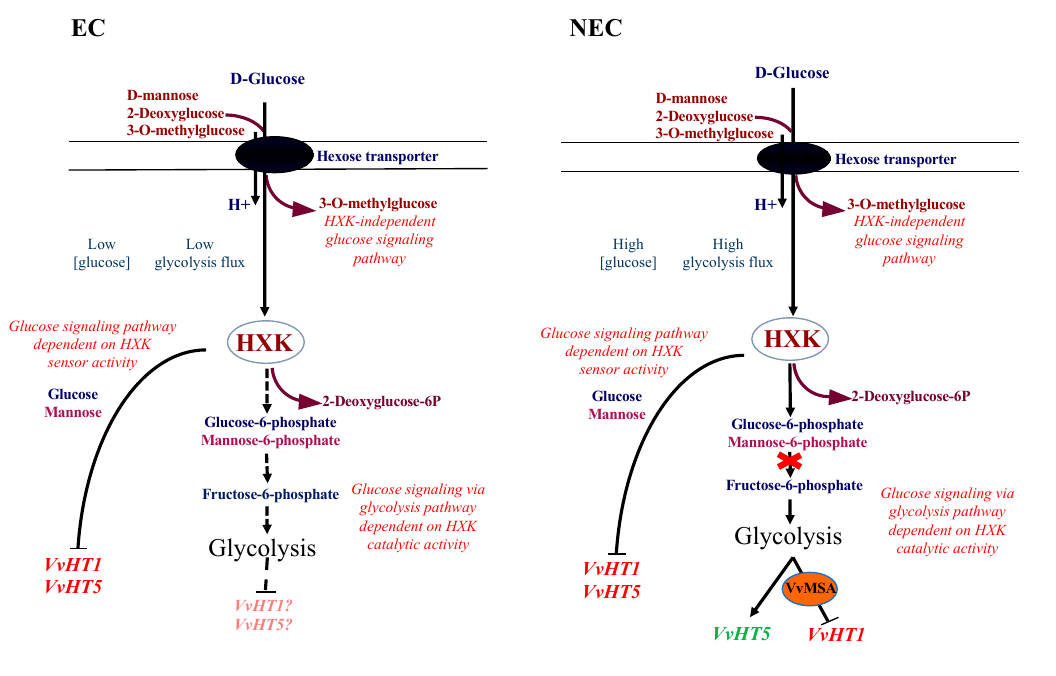
Figure 16. Hypotheses for the regulation of VvHT1 and VvHT5 expression in glucose signaling pathways. In embryogenic cells (EC), characterized by low glucose content and low glycolysis flux, the HXK-dependent glucose signaling triggers the inhibition of both the studied genes. Mannose may be detected by the cytosolic sensor HXK, and produces the same effects as those of glucose. In grape, mannose may also be phosphorylated as a substrate of HXK catalytic activity, and the resulting mannose-6-P could be metabolized, thereby allowing a glucose signaling pathway dependent on glycolysis. The less pronounced effect of 2DOG-blocked isomerization of glucose-6-phosphate to fructose-6-phosphate could be explained by its minimal impact on low glycolysis activity. In non-embryogenic cells (NEC), by presenting a high glucose content and a high glycolysis flux, inhibition by 2DOG of glucose-6-phosphate to fructose-6-phosphate isomerization leads to metabolic disruption. This metabolic switch results in VvHT1 repression by glycolysis-dependent glucose signaling, which is mediated by its transcriptional regulator VvMSA. Inversely, the upregulation of the VvHT5 expression by glycolysis-dependent glucose signaling appears independent from VvMSA.